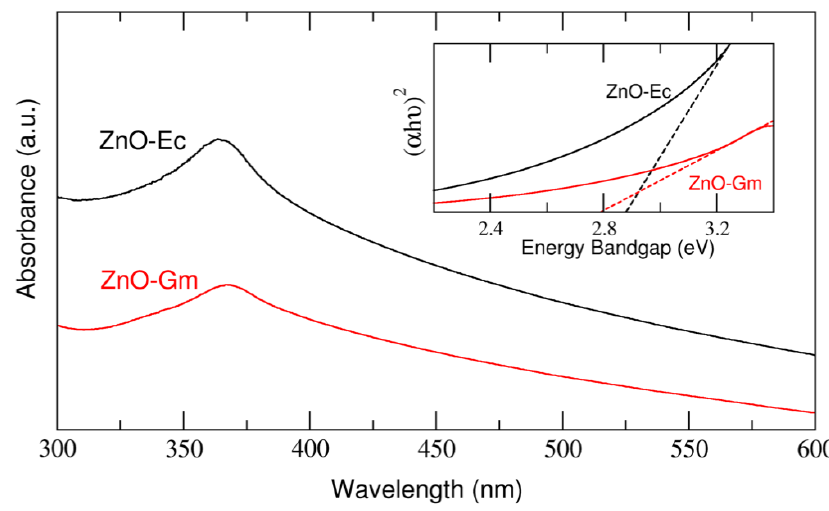
Figure 3. UV-Vis spectra and energy band gap of green synthesized ZnO samples. ZnO-Gm nanoparticles produced from mangosteen peel crude extract whereas ZnO-Ec samples generated from water hyacinth crude extract.